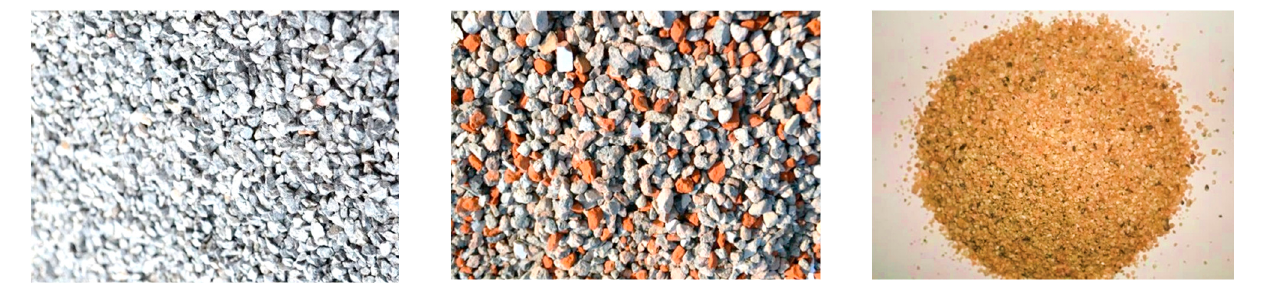
Figure 1. Recycled coarse aggregate content (RCA) production process.